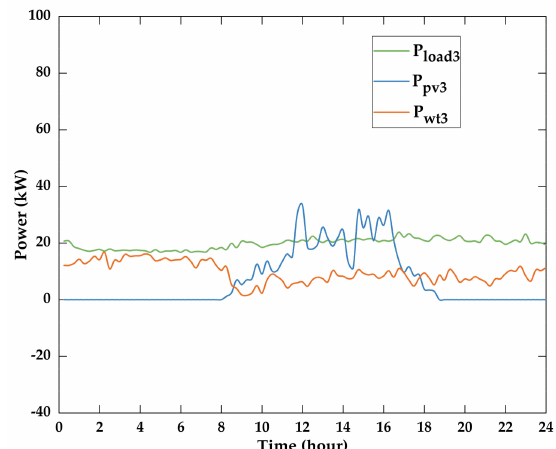
Figure 12. Power in module B.